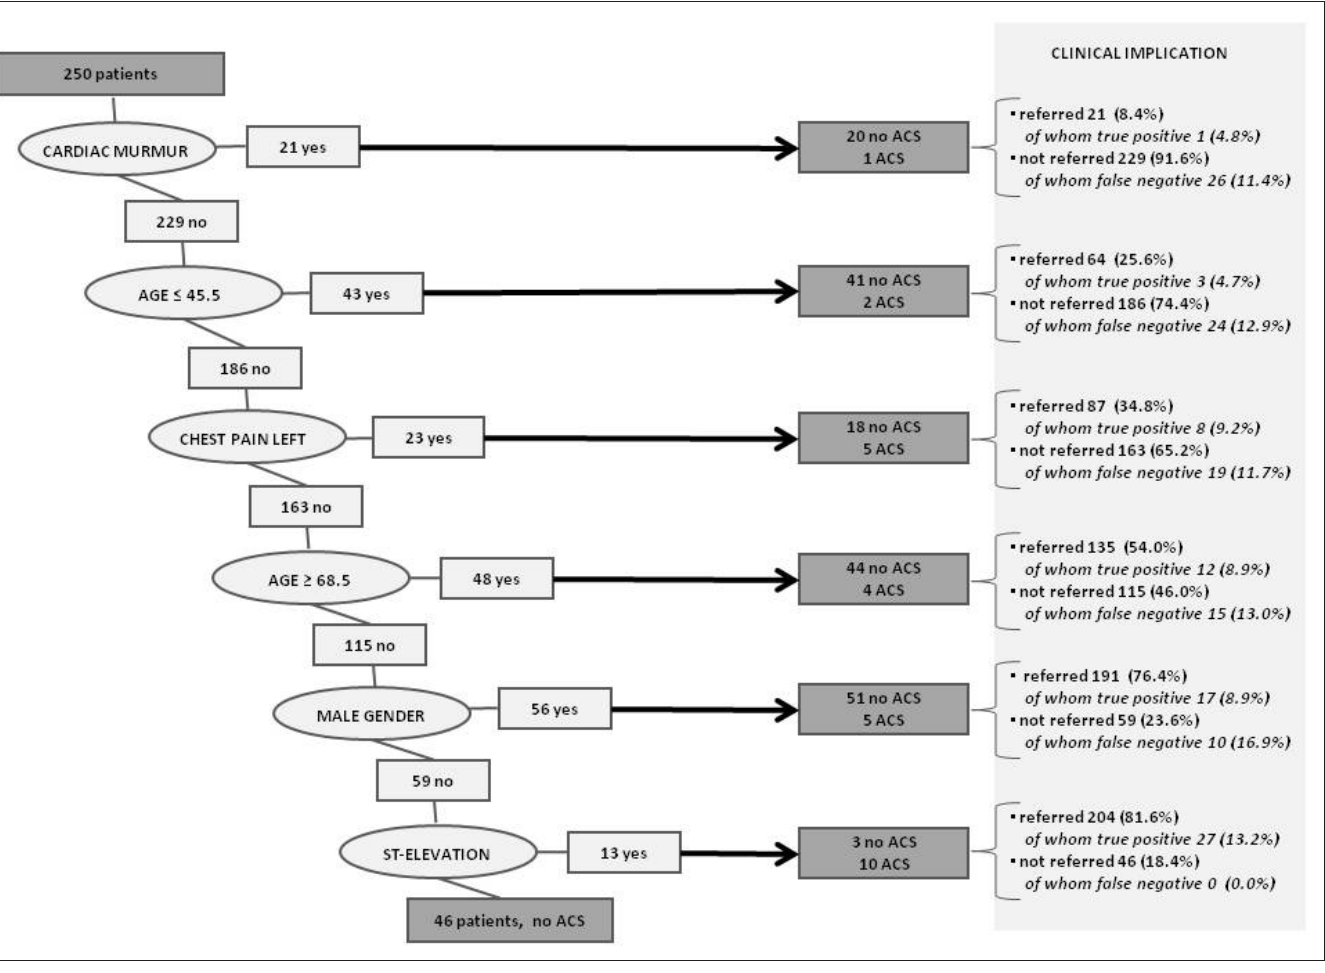
Figure 2 Classification tree for acute coronary syndrome. ACS = acute coronary